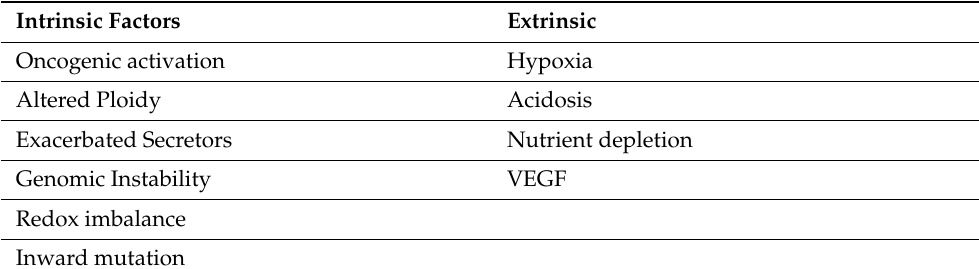
Table 1. Factors that increase